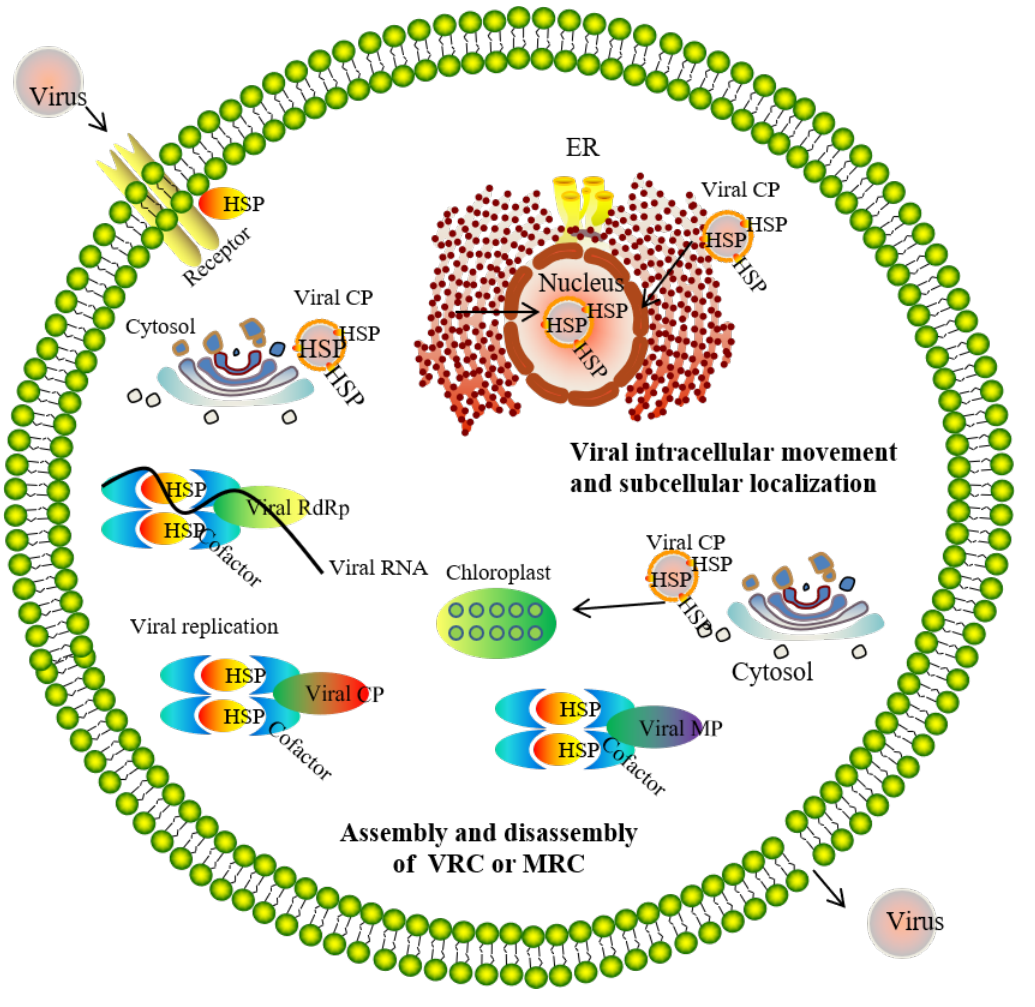
Figure 3. HSPs exhibit different functions in the viral macromolecular complex. Abbreviations: HSP, heat shock protein; ER, endoplasmic reticulum; MRC, macromolecular protein complexes; Viral CP, viral coat protein; Viral MP, viral movement protein; Viral RdRp, viral RNA-dependent RNA polymerase; VRC, viral replicase complex. Table 1. The interaction between the MC and viral components.